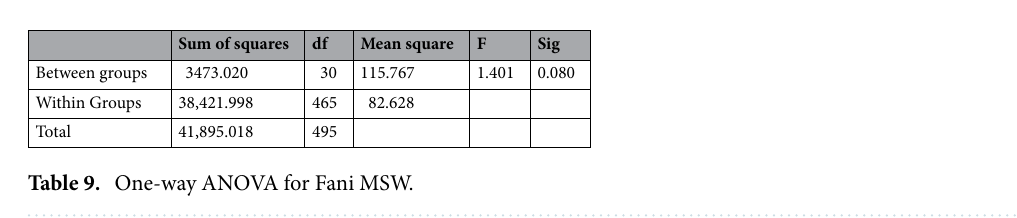
Table 9. One-way ANOVA for Fani MSW.